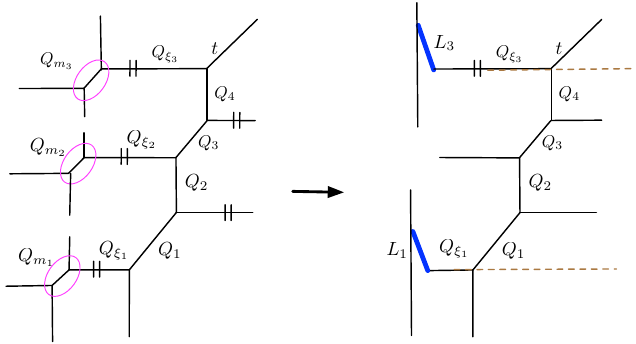
Figure 22 . There are two original lines for this theory. On Higgs branch, we need to cut some internal lines. The effective Chern-Simons level for this brane web is